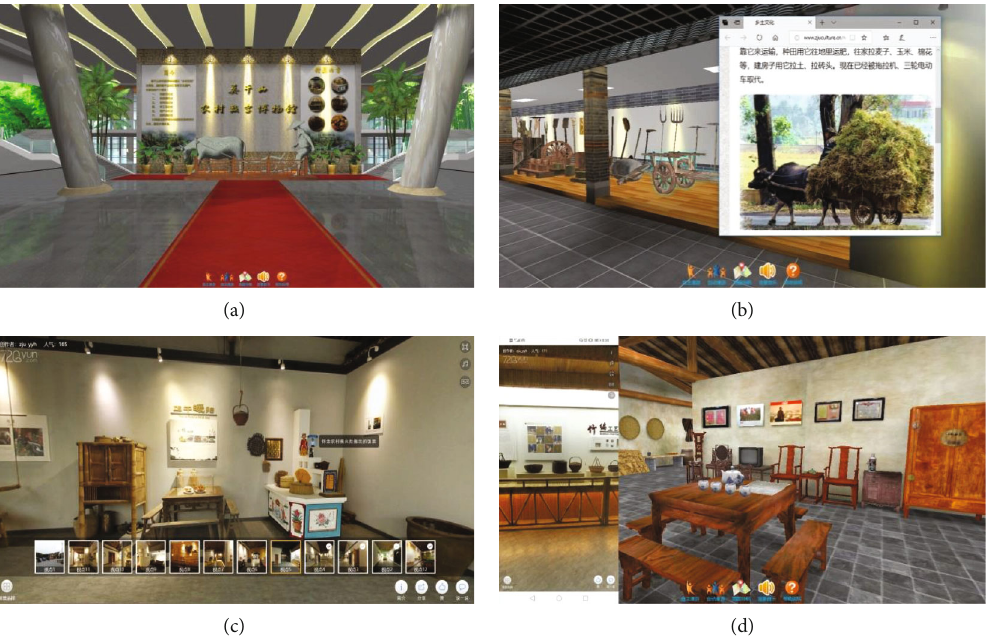
Figure 2: (a) Mt. Mogan rural virtual museum scene based on Unity. (b) The exhibition introduces of the Mt. Mogan rural virtual museum. (c) Mt. Mogan rural virtual museum scene based on 720yun VR panoramic publishing platform. (d) The display e ff ects of the Mt. Mogan rural virtual museum based on mobile phone and